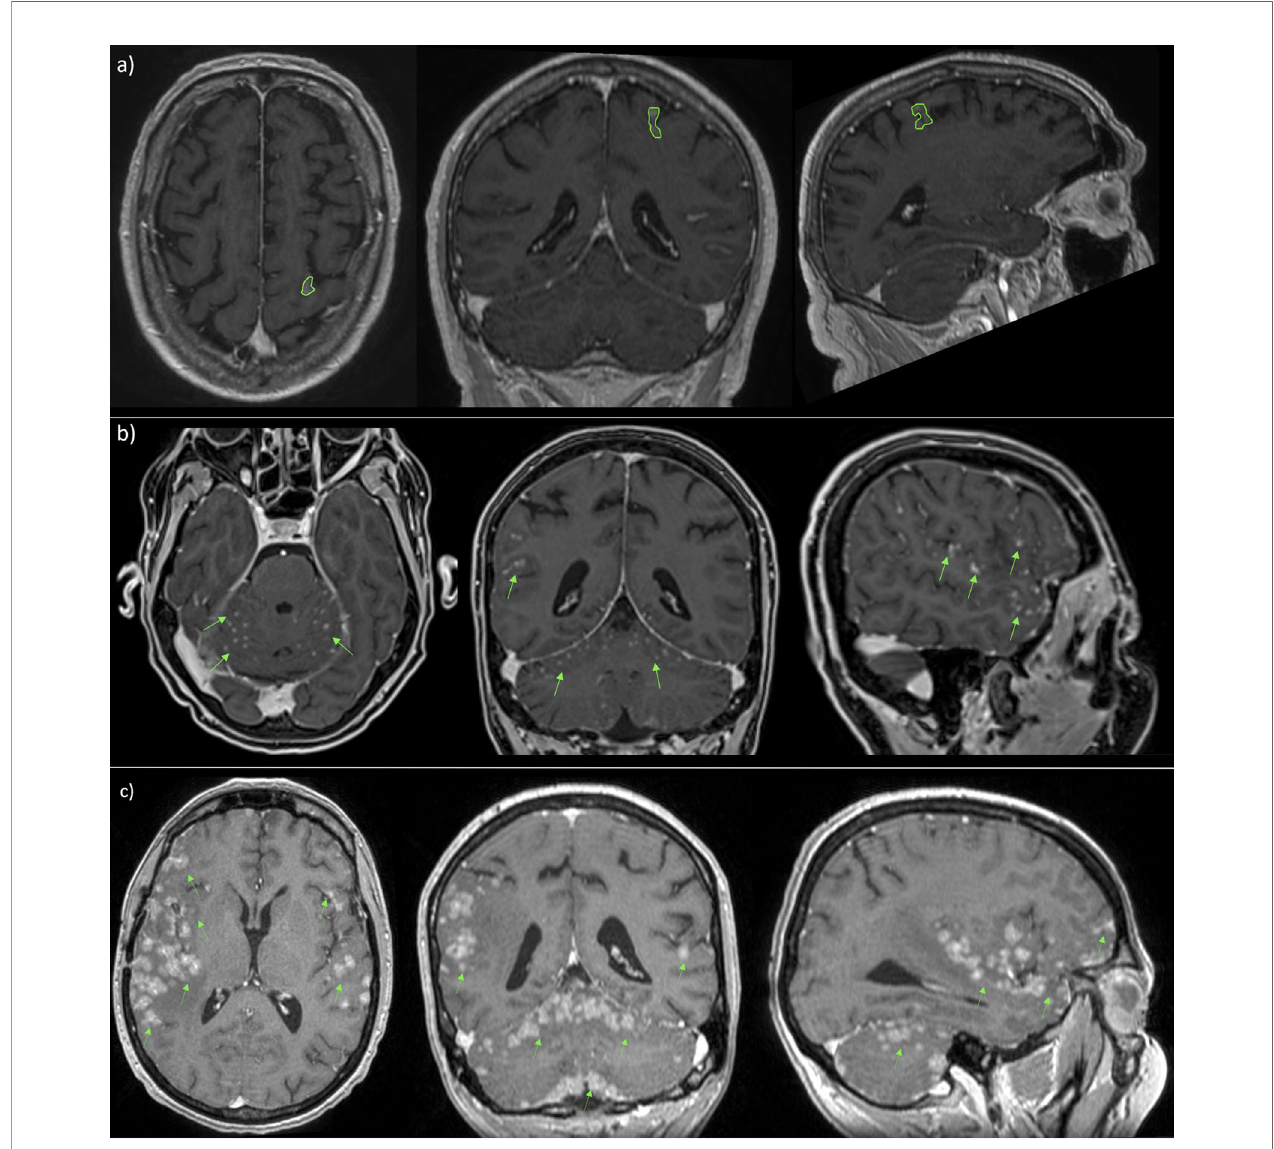
FIGURE 7 | MRI scans in patient with nodular (A) , linear (B) and both types (C) of leptomeningeal